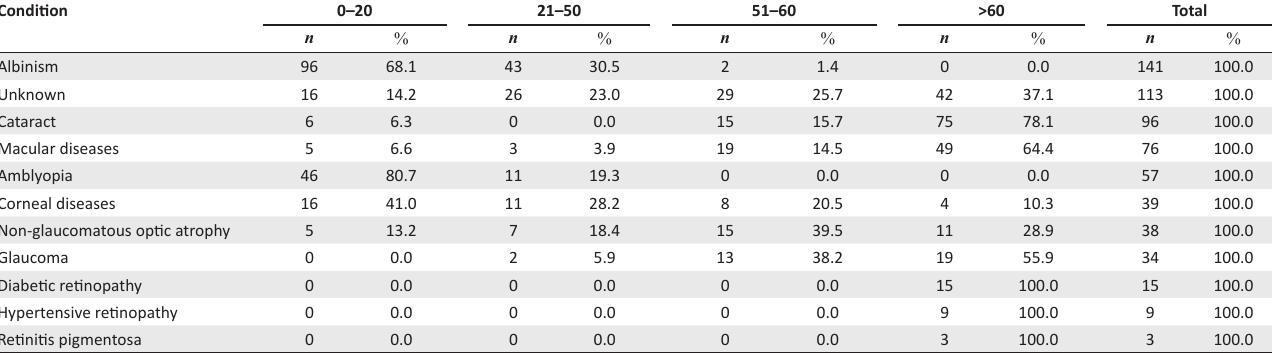
TABLE 4: Causes of low vision in different age groups of 621 patients presenting at the low vision clinic of the Department of Optometry, University of KwaZulu-Natal.